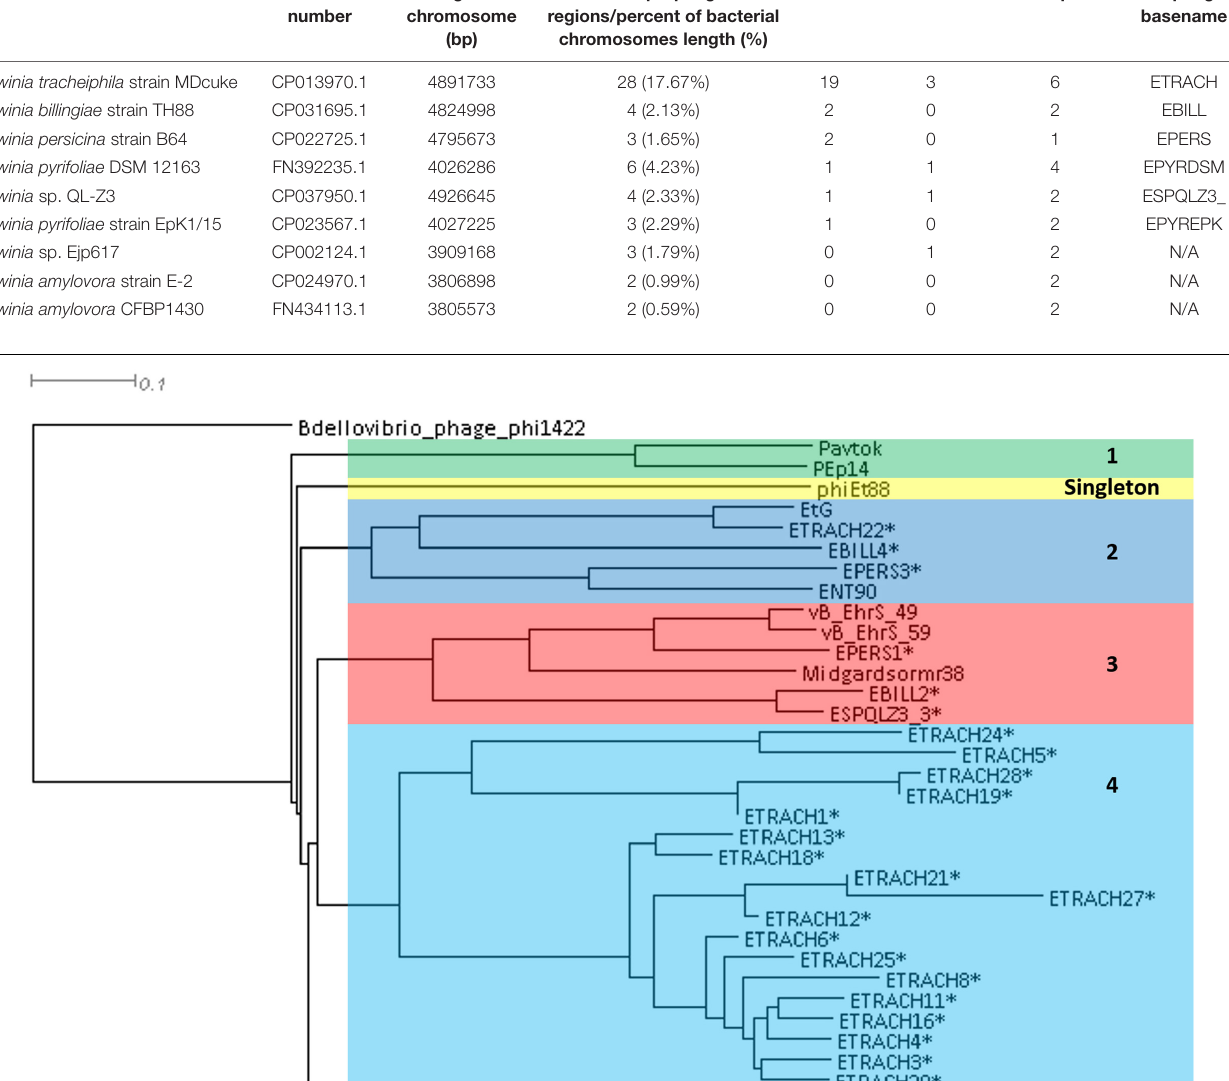
TABLE 1 | Putative prophage region predictions in the publicly available complete genome sequences of Erwinia strains as identified by PHASTER. Isolate